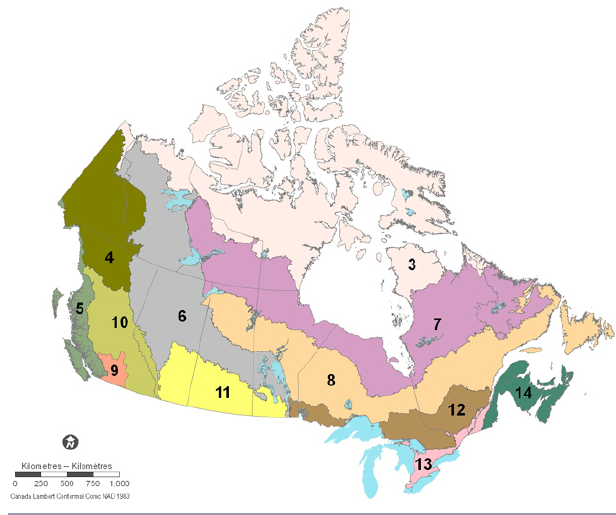
Fig. 1 . Map of Bird Conservation Regions (BCR) in southern Canada. Agricultural regions are covered by: 5 = Northern Pacific Rainforest, 6 = Boreal Taiga Plains, 8 = Boreal Softwood Shield, 9 = Great Basin, 10 = Northern Rockies, 11 = Prairie Potholes, 12 = Boreal Hardwood Transition, 13 = Lower Great Lakes/St. Lawrence Plain, 14 = Atlantic Northern Forest (Map source: Bird Studies Canada 2013, http://www.birdscanada.org).